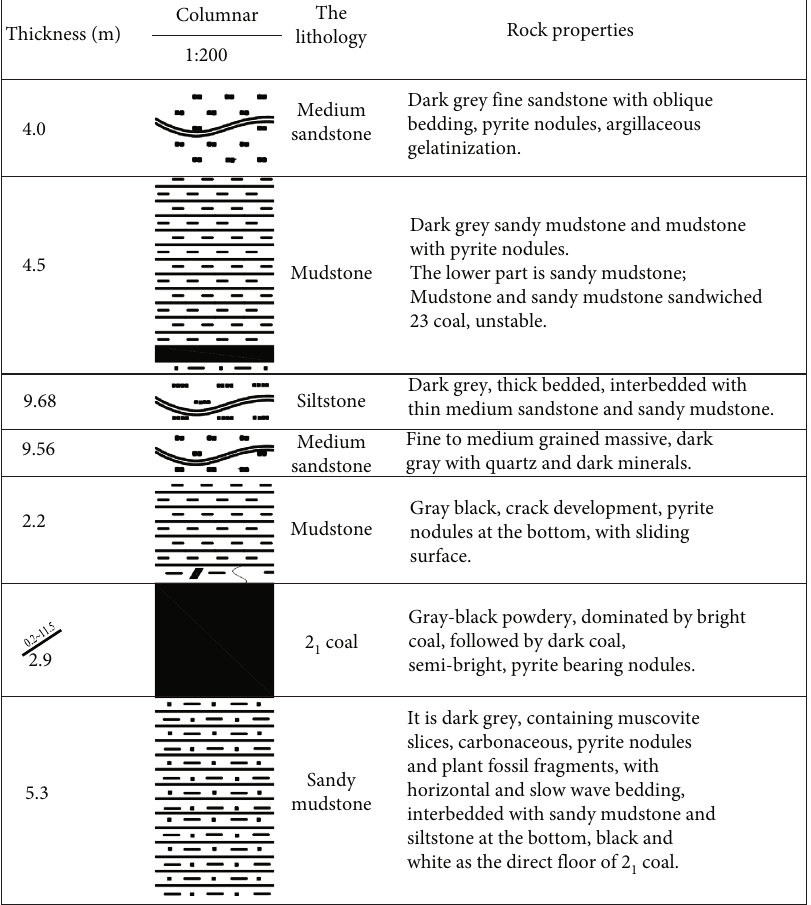
Figure 3: Stratum histogram of the Xin ’ an coal